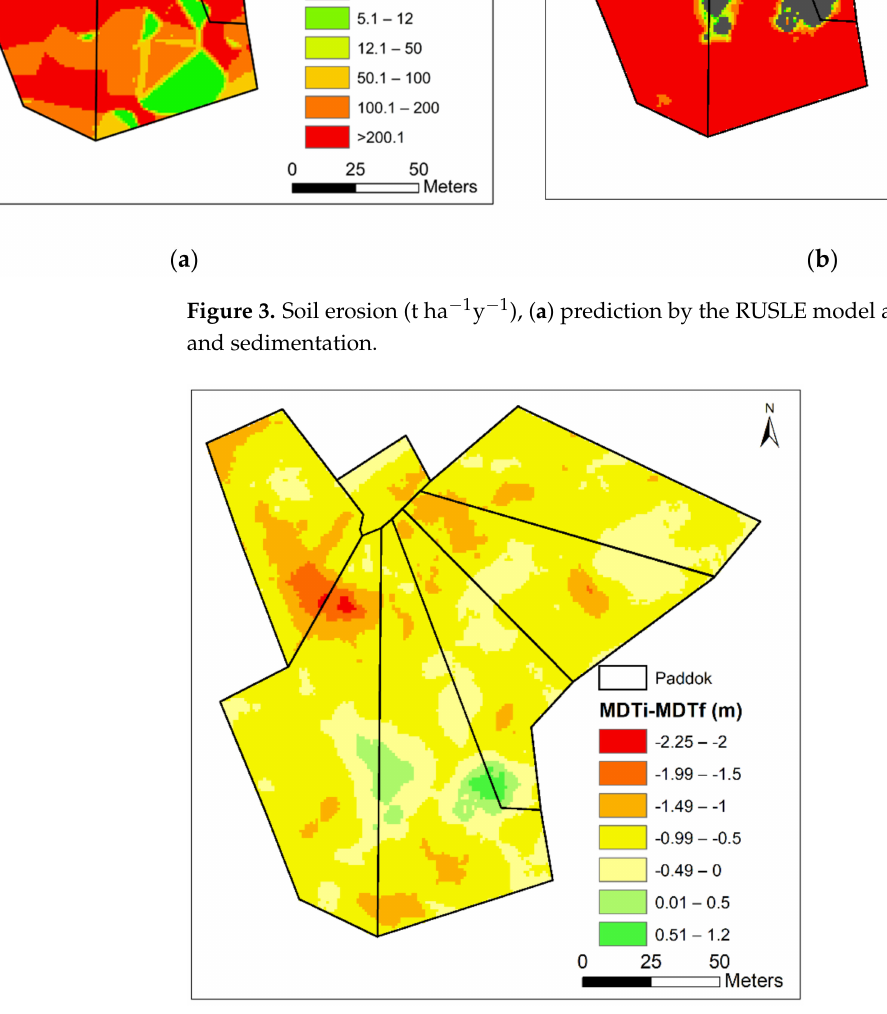
Figure 4. Location in the study area of sites with soil loss (m; negatives values) and sites with sedimentation (m; positive